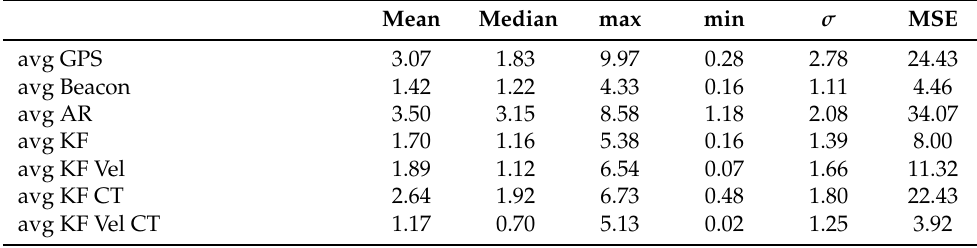
Table 11. Evaluation (Dataset 2): GPS, beacon, and AR; distance to the ground truth.